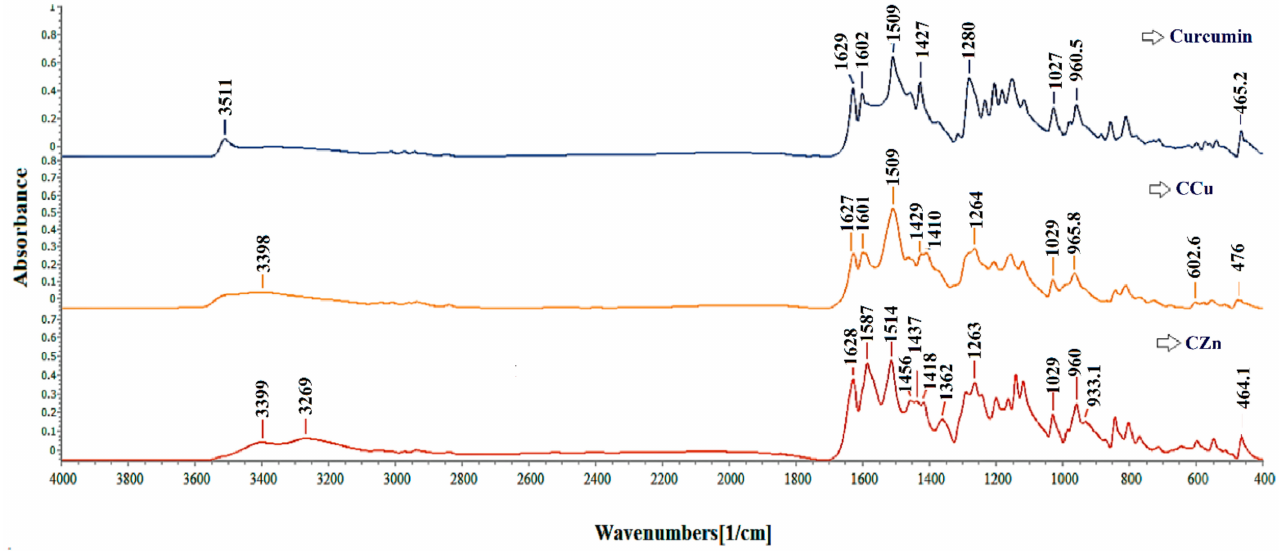
Figure 4. FTIR spectrum for free curcumin (FC) compared with the FTIR spectrum for the curcumin complexes with copper (CCu) and zinc (CZn)